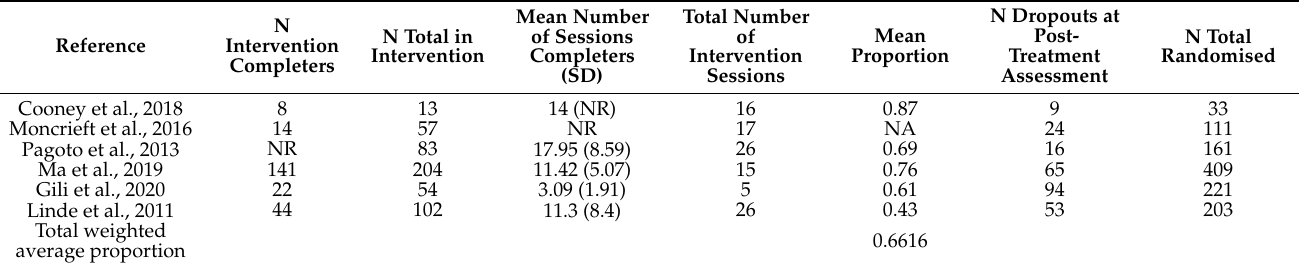
Table 2. Adherence outcome data (completers and mean proportion of session completed) and dropout data.